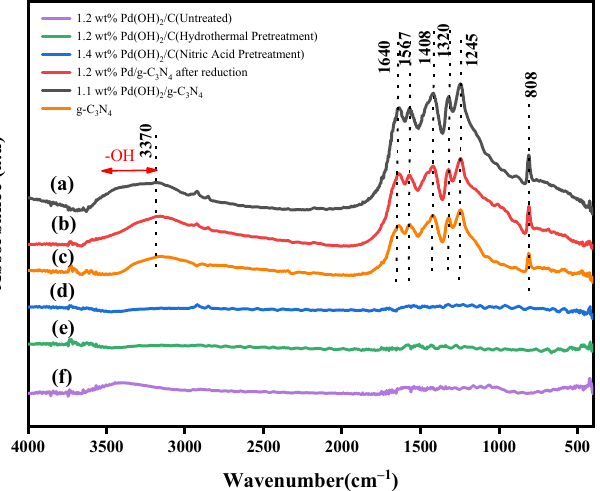
Figure 1. FT-IR spectra of the samples with different of Pd loading determined by ICP-OES.